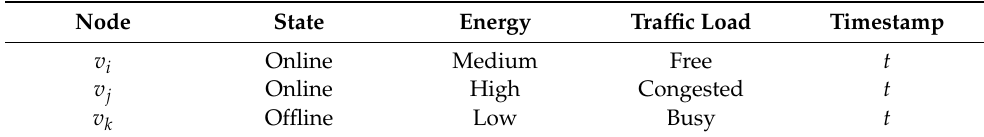
Table 2. Link state